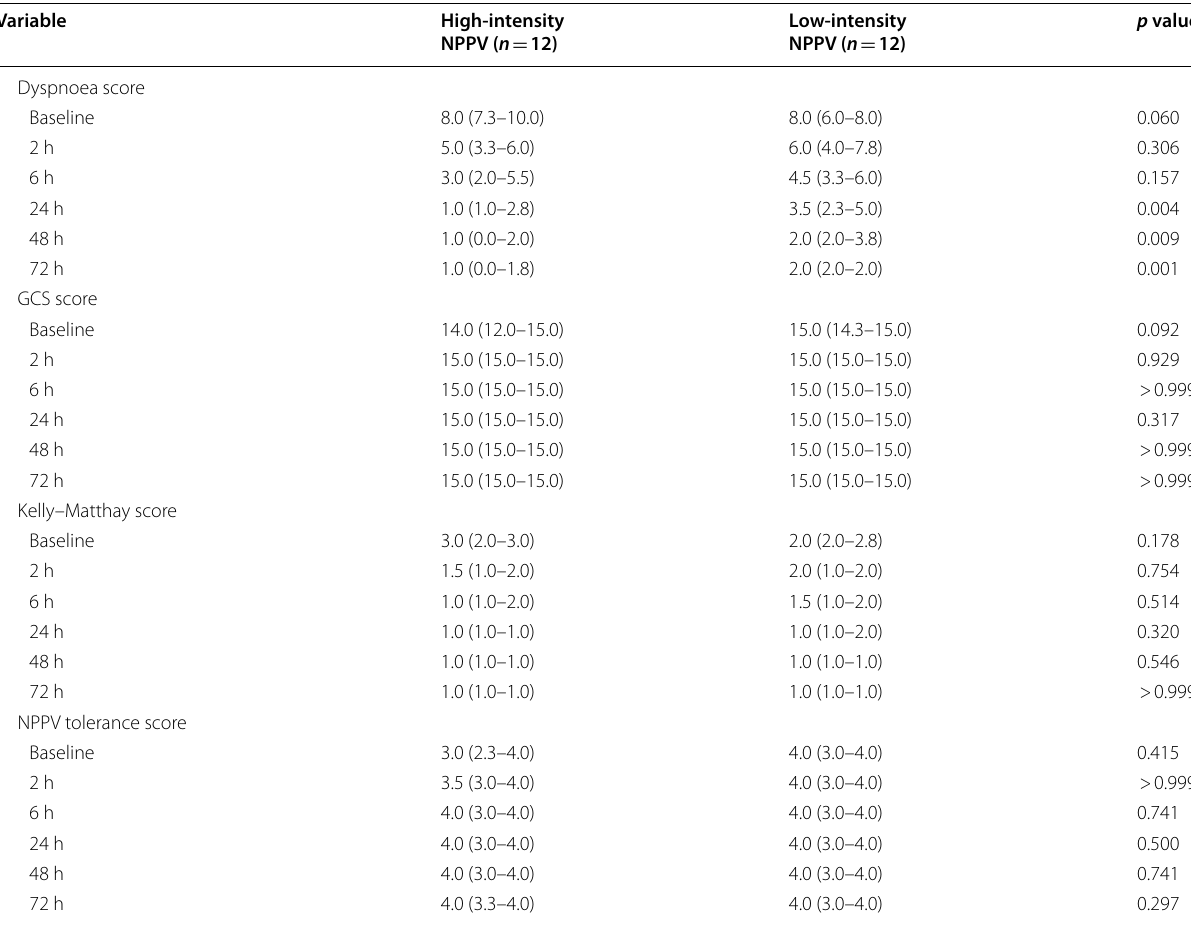
pro-B-type natriuretic peptide, troponin I, creatine kinase isoenzyme, or echocardiographic findings, dif- fered significantly 24 h after randomisation between the two groups (see Additional file 1: Table S3 for more details). There were no significant between-groups dif- ferences in plasma levels of TNF-α, IL-1β, IL-6, IL-8, IL-10, or MIP-2 24 h after randomisation (see Fig. 6 and Additional file 1: Table S3 for more details). During NPPV, the high-intensity NPPV group did not have a higher incidence of severe NPPV intolerance, but did have a numerically higher incidence of abdomi- nal distention compared to the low-intensity NPPV group (Additional file 1: Table S3). No severe alkalosis occurred, and no patient required